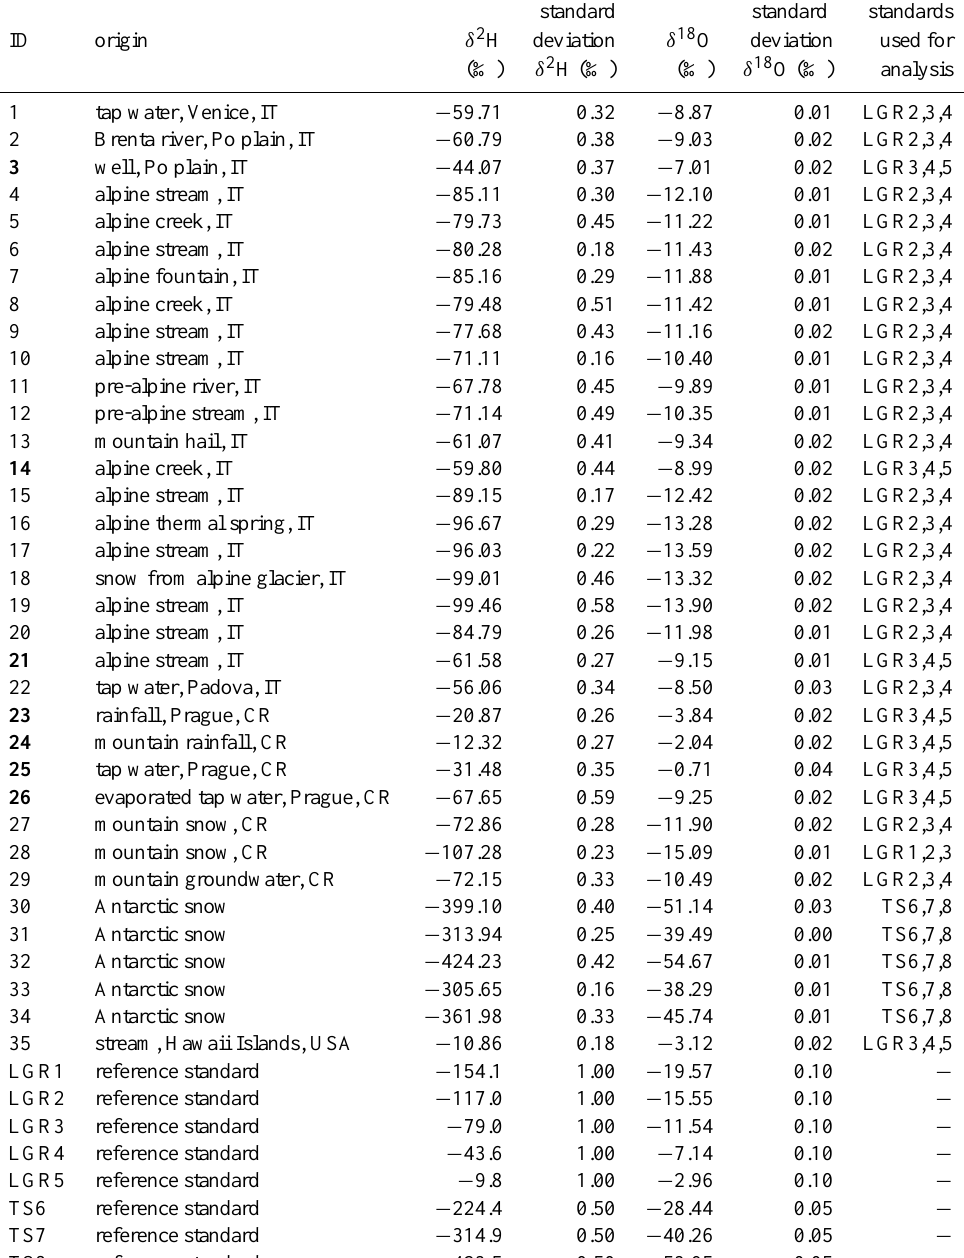
Table 1. Geographical origin and isotopic values (analyzed by mass spectrometry) of the study samples and reference standards. IT: Italy, CR: Czech Republic, USA: United States of America. Repeated samples are marked in